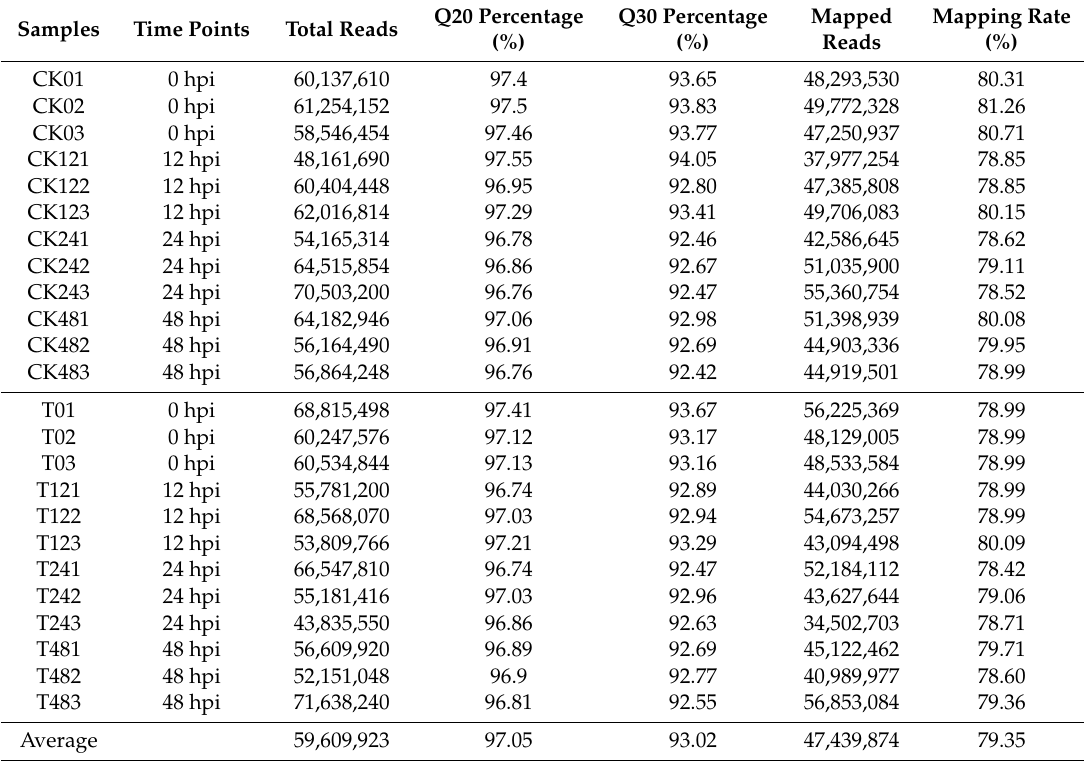
Table 1. Number of high-quality, filtered rate. CK, control; T, inoculated with P. leucotricha .